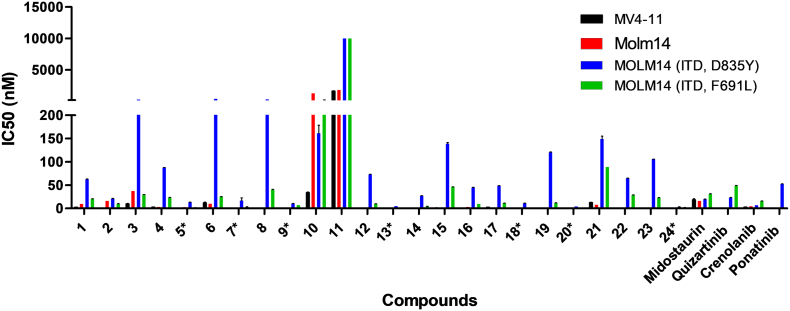
Anti-proliferative activity of second-generation compounds. The IC50 values against MV4–11 (black), MOLM-14 (red), MOLM-14 (ITD, D835Y) (blue) and MOLM-14 (ITD, F691 L) (green) cells were plotted for each compound. Compounds with 15 nM or less IC50 against all 4 cell lines are marked with *. Each bar represents the average of triplicates plotted using GraphPad Prism software (GraphPad, La Jolla, CA). (For interpretation of the references to colour in this figure legend, the reader is referred to the web version of this article.)